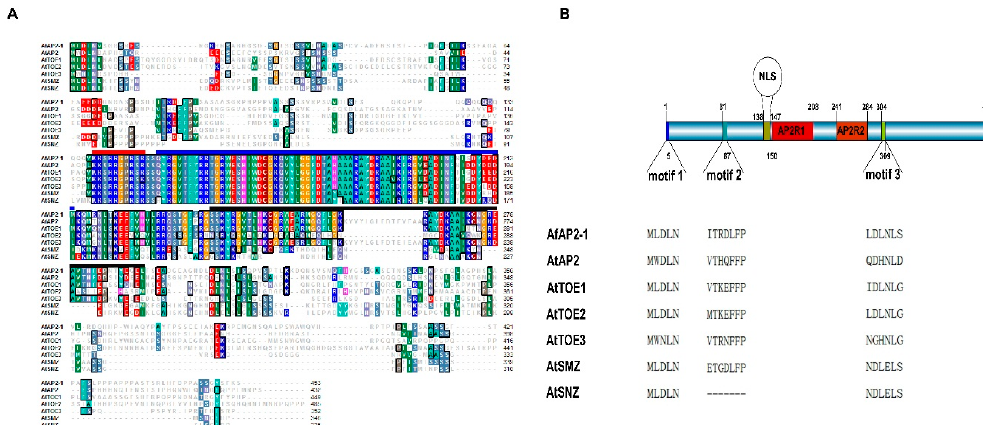
Figure 1. Alignment of the deduced amino acid sequences of AfAP2-1 with AP2 and AP2-like proteins of Arabidopsis and the structure of AfAP2-1. ( A ) Alignment of the deduced amino acid sequences of AfAP2-1 with AP2 and AP2-like proteins of Arabidopsis. The red line indicates the completely conserved putative nuclear localization signal (NLS) sequences, and the blue and black lines indicate the two AP2 domains (AP2R1 and AP2R2). At: Arabidopsis thaliana. AtAP2: AEE86718; AtTOE1: AEC08137; AtTOE2: AED97280; AtTOE3: AED98311; AtSMZ: AEE79323; AtSNZ: AEC09650; ( B ) The structure of AfAP2-1. The sequences of three motifs of AfAP2-1 and all six AP2 members in Arabidopsis are shown. “-“ represents the gap produced in the multiple alignments.